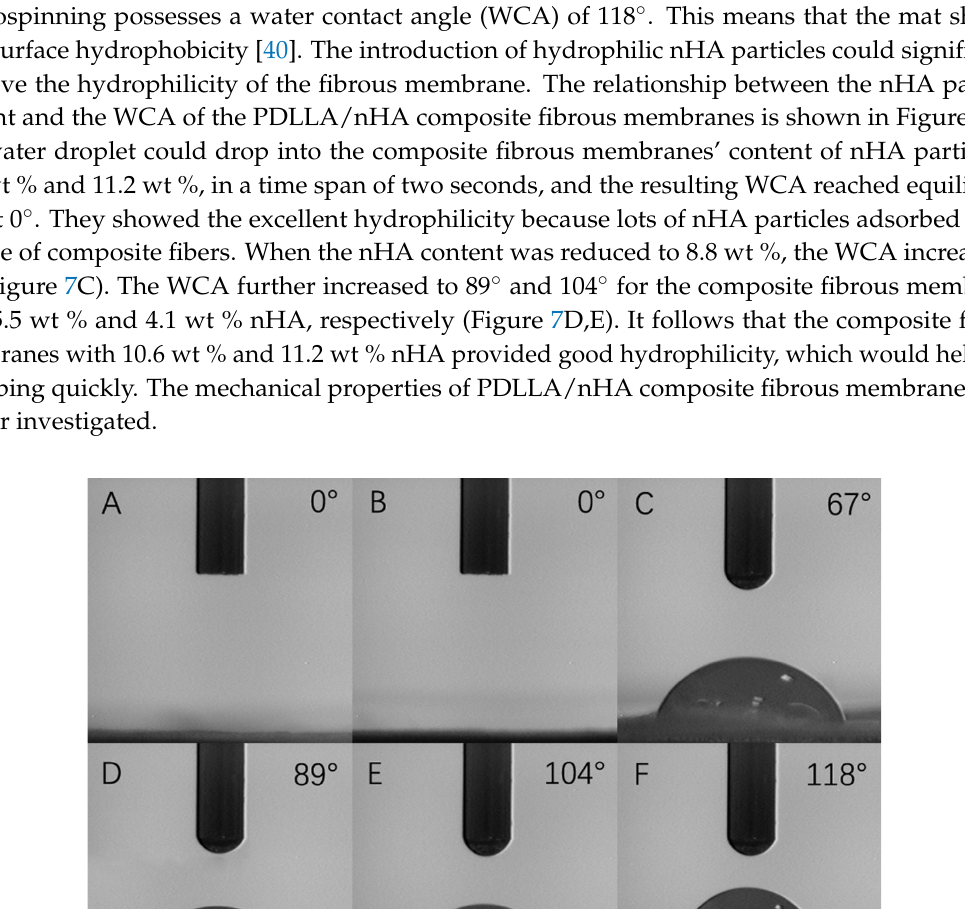
Table 1. nHA content of PDLLA/nHA composite fibrous membranes.